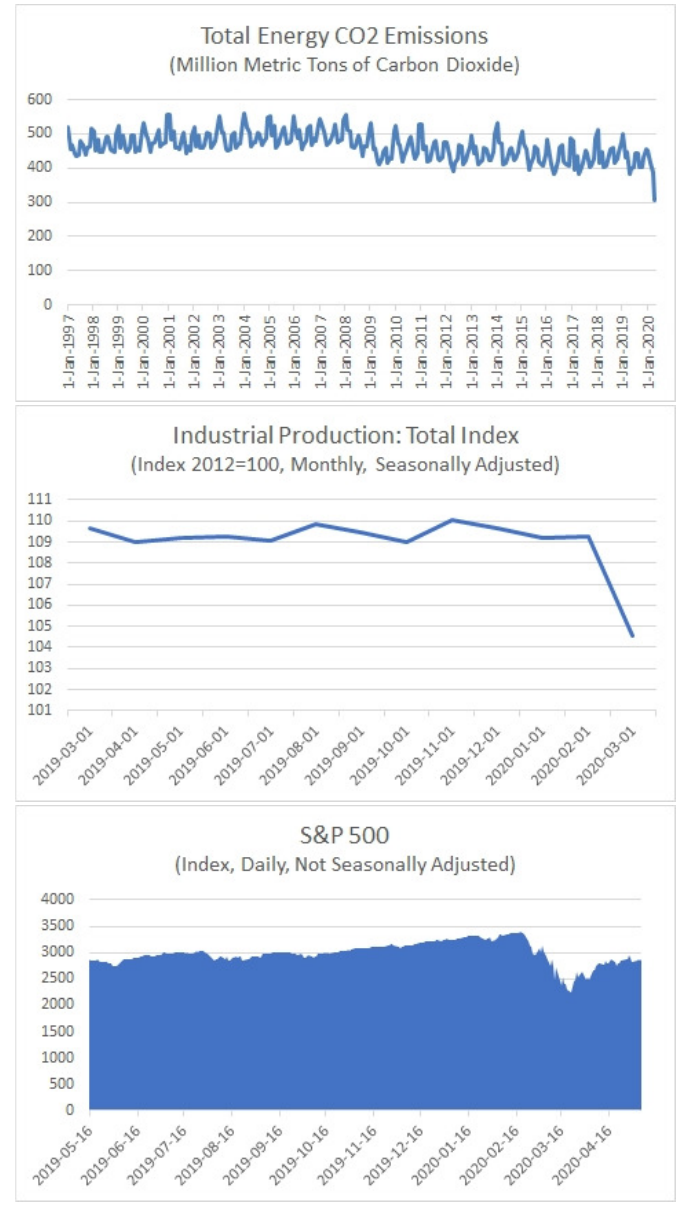
Figure 1. Monthly U.S. Total Fossil Fuel CO 2 emissions ( top ), Monthly U.S. Industrial Production Index Seasonally Adjusted ( middle ) and S&P 500 Index ( bottom ) daily close. Note: CO 2 emissions are sourced from U.S. Energy Information Administration. Industrial production and S&P 500 are sourced from the Federal Reserve Bank of St.